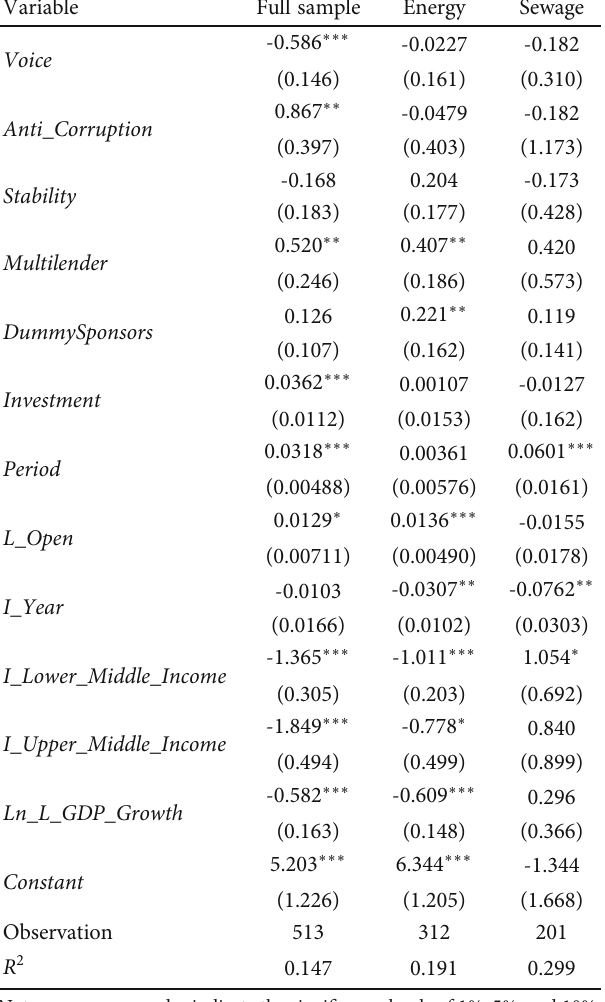
Table 9: Results of regression model 2: factors determining the internal risk structure of a Green PPP